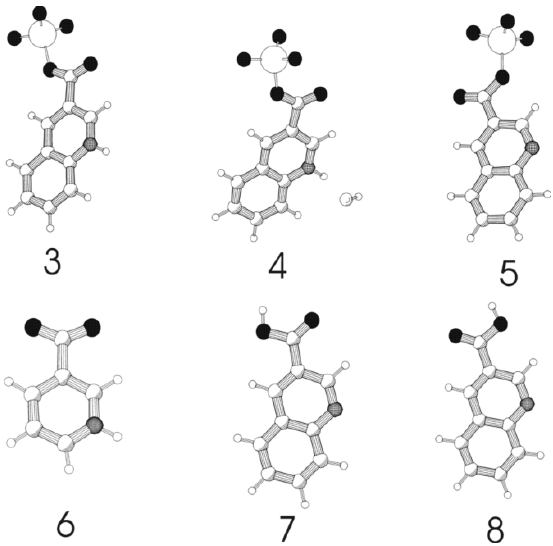
Figure 3. The optimized structures 3 - 8 at the b3lyp/6-311G* level of